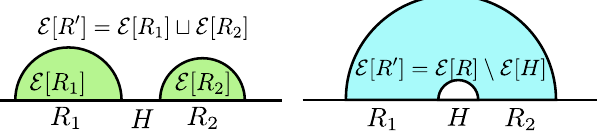
FIG. 4. Two possible geometries for the entanglement wedge E ½ R 0 (cid:2) of a boundary region R 0 ¼ R ⊔ R 1 2 with two connected components separated by the interval H . In the left diagram, the ⊔ χ minimal surface is χ R 0 ¼ χ R R 2 , and the entanglement wedge is 1 E ½ R 0 (cid:2) ¼ E ½ R ⊔ E ½ R 1 (cid:2) 2 (cid:2) . In the right diagram, the minimal surface is χ χ ⊔ χ R ¼ R HR R 0 ¼ R H , where 1 2 , and the entanglement wedge is E ½ R 0 (cid:2) ¼ E ½ R (cid:2)n E ½ H (cid:2)